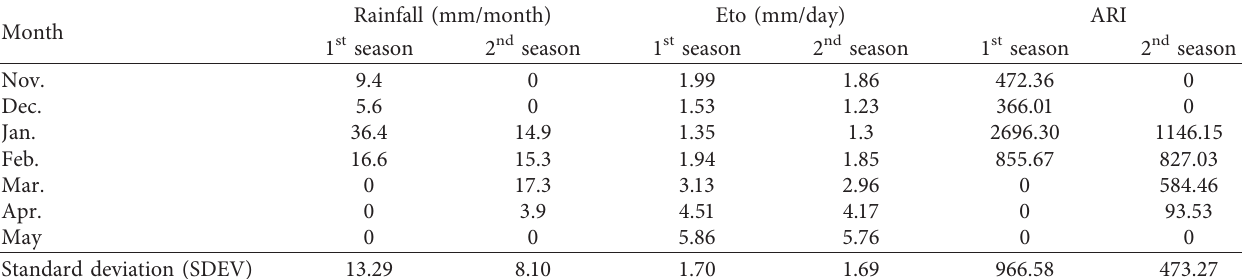
Figure 1: GDD for different planting dates and Agricultural Rainfall Index during the two seasons (2017/2018 and 208/2019). Table 4: Rainfall (mm · day − 1 ), reference evapotranspiration ET · day − 1 ), Agricultural Rainfall Index, and standard 0 (mm